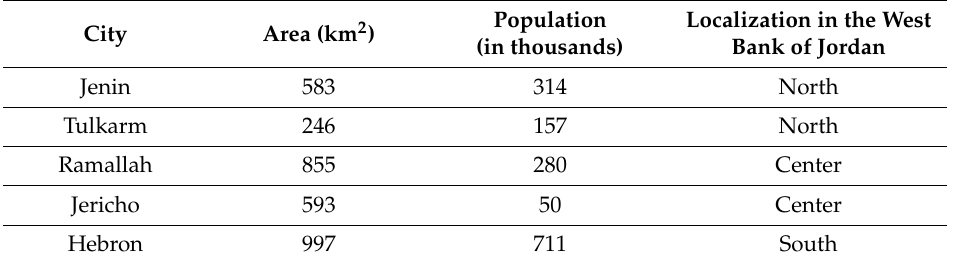
Table 5. Area and population of cities used in this research.